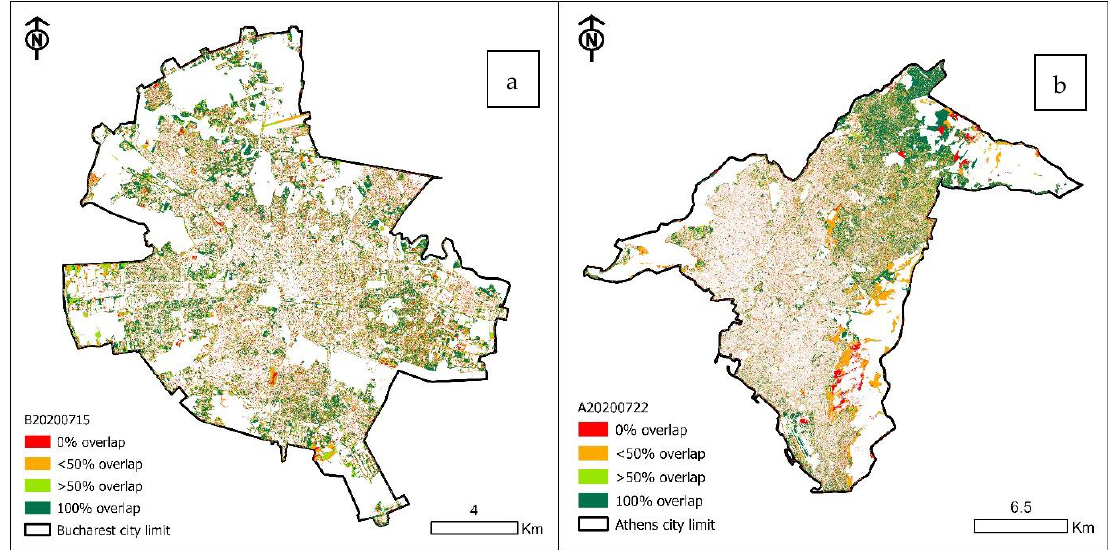
Figure 3. Small urban green area distribution for Bucharest ( a ) and Athens ( b ), from 2018 – 2020. The percentage of overlaps highlights the certainty of the presence of small urban green areas in those locations. In the case of both cities, around 55% of the identified small green areas remain in this category almost across the entire analyzed timeframe. The areas with a high percentage of overlaps have different distributions across the two cities.